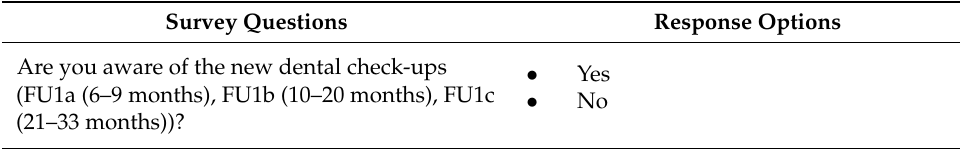
Table 1. Second section of the questionnaire with survey questions and